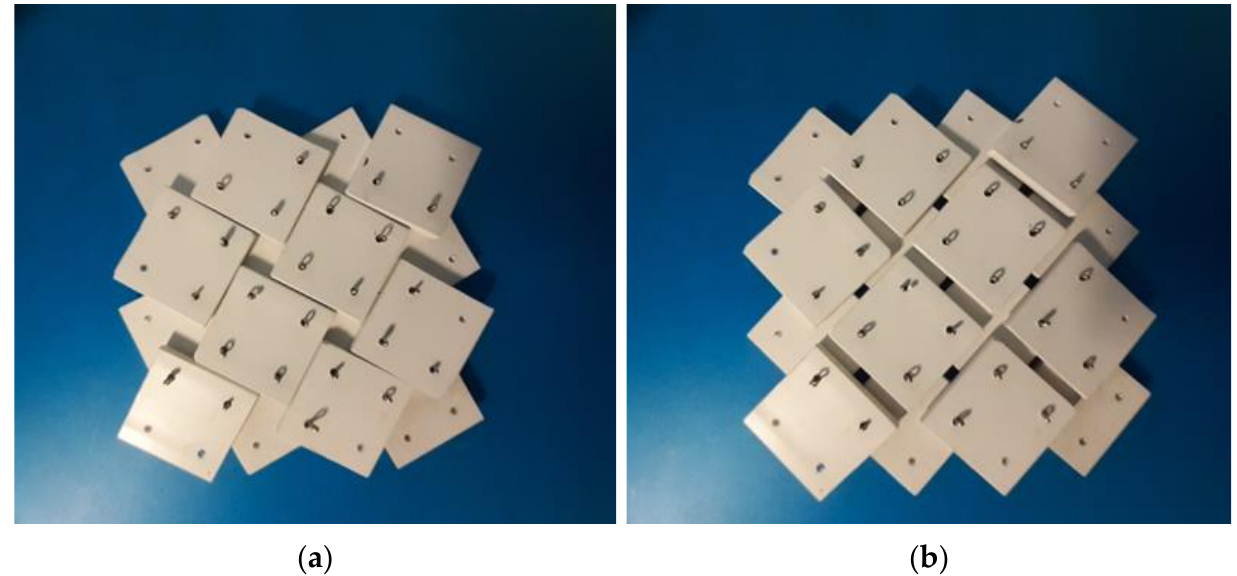
Figure 8. Photographs of auxetic structures 4 × 4 for x = 0.21 in the closed ( a ) and open positions ( b ).